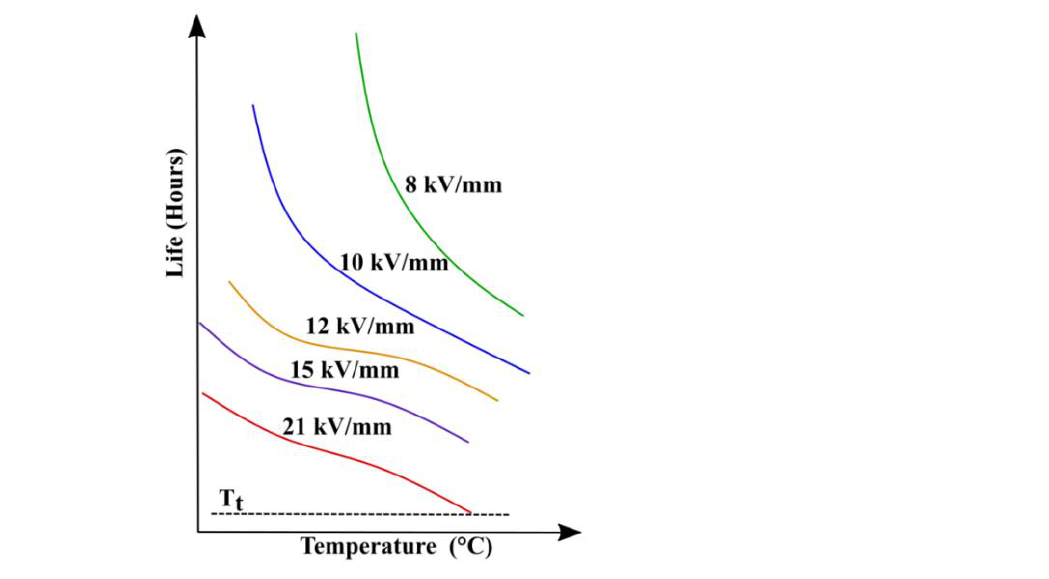
Figure 8. Thermal lifelines of XLPE cable at different values of electrical stress adapted with permission from [53].